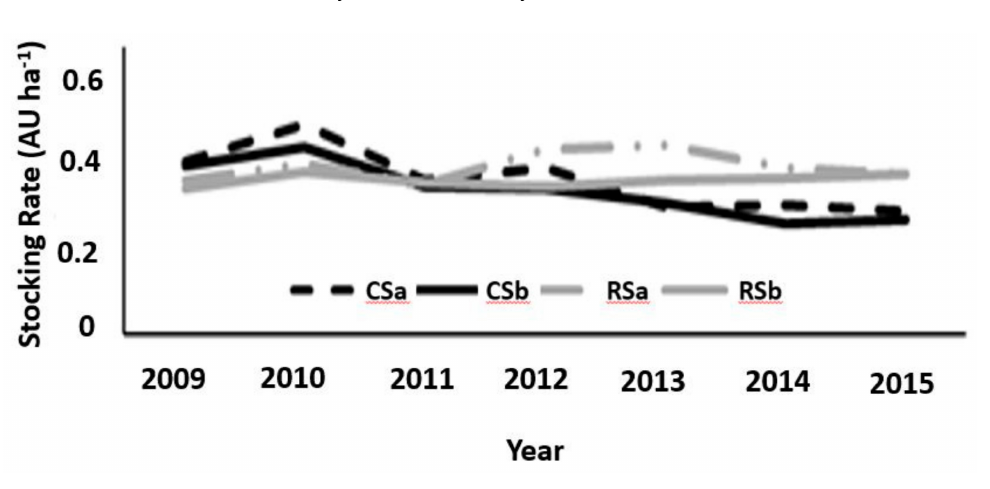
Figure 5. Stocking rate for each replicate from 2009 to